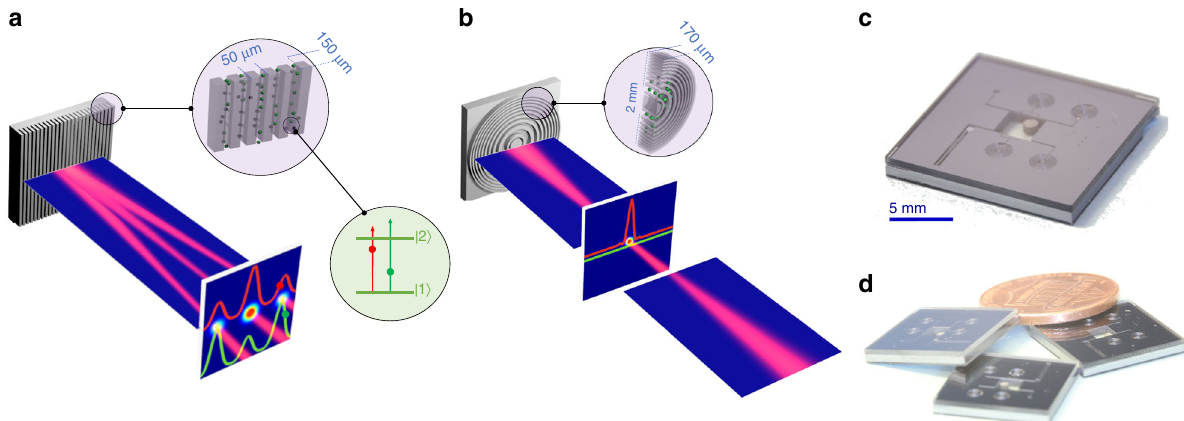
Fig. 1 Atomic diffraction optical elements concept of operation. a Artistic rendition of a diffractive atomic grating whose diffraction pattern is controlled by the atomic state of atoms embedded within its channels. At the far- fi eld plane, two different diffractive patterns are depicted corresponding to two different detuning from the optical transition (illustrated in the green circle). b Artistic rendition of an atomic switchable Fresnel lens. In the focal plane, two states of operation are shown, which correspond to two different detuning ’ s from the atomic state: the red state corresponds to the lens in the on-state, and the green to the off-state. c A photograph of an ADOE consisting of a rubidium reservoir connected to a few manifestations of Fresnel lens. d A photograph of three typical diced devices compared to a